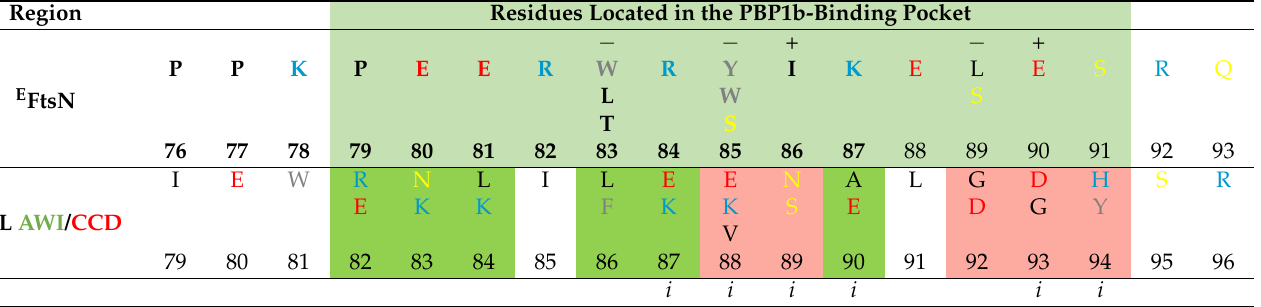
Table 1. E FtsN and FtsL AWI/CCD domains. Region Residues Located in the PBP1b-Binding